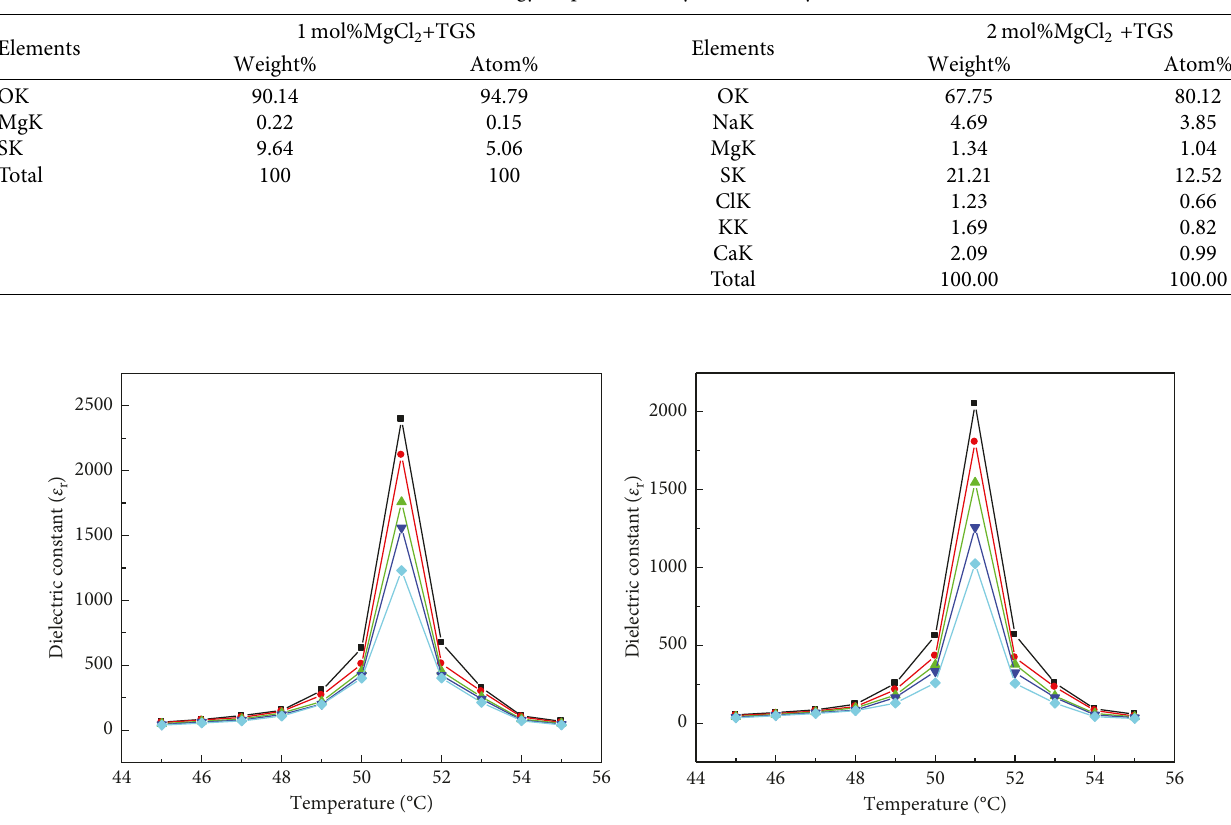
2 -doped TGS crystals.